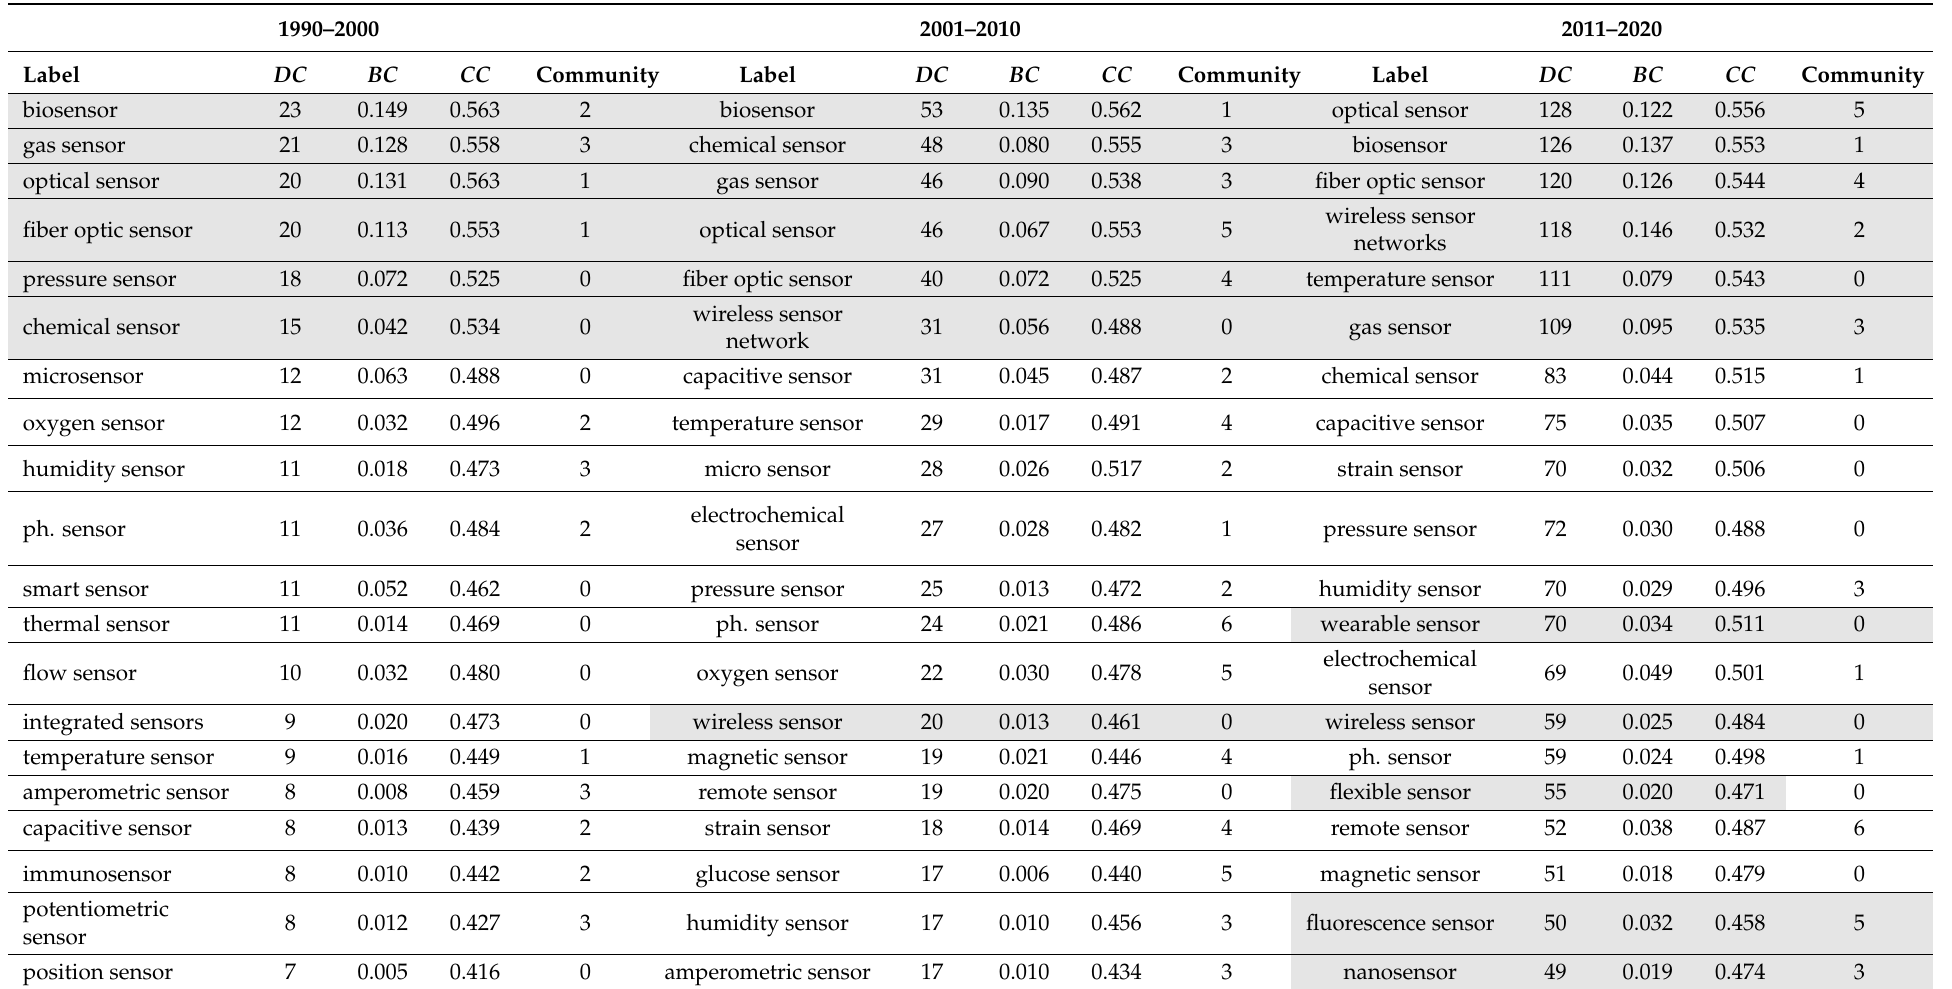
Table 2. Top 20 items in sensor research with measures of networks from 1990 to